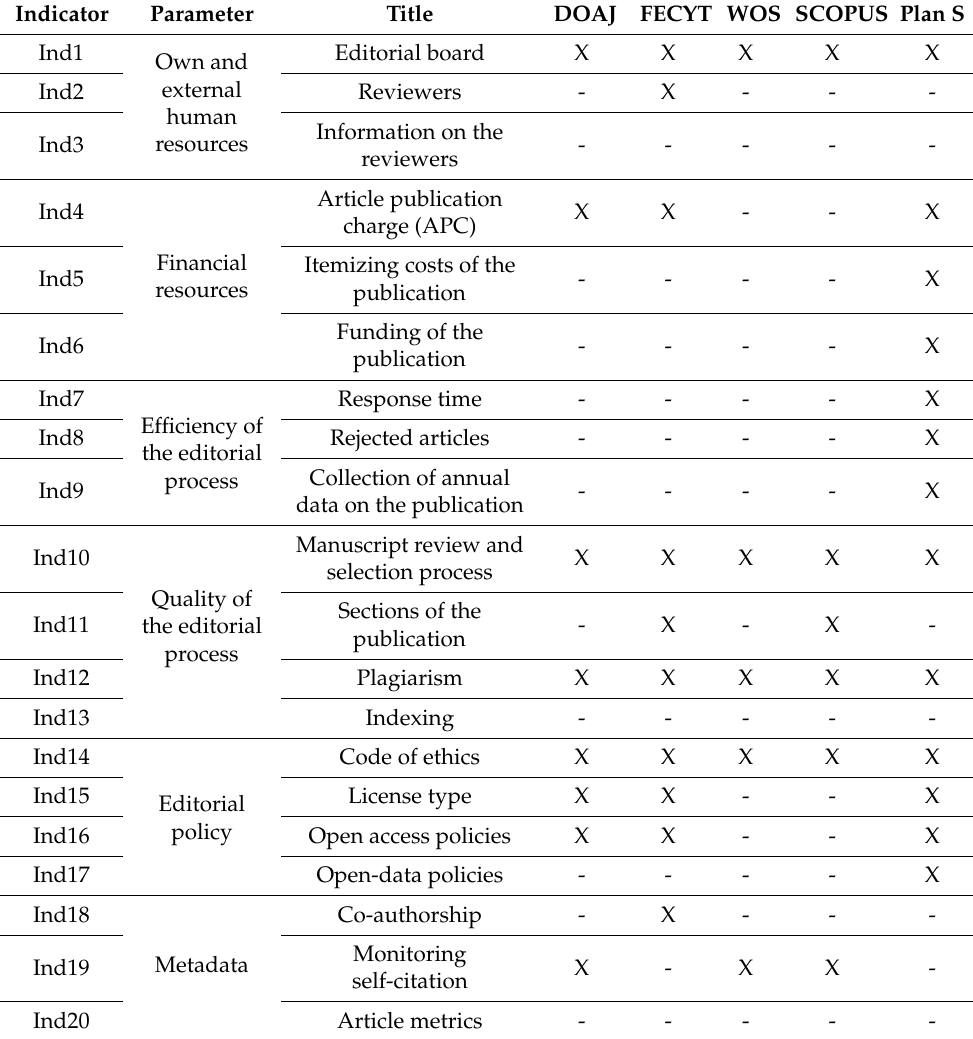
Table 2. Indicators used for analysis of journals and correspondence with sources of